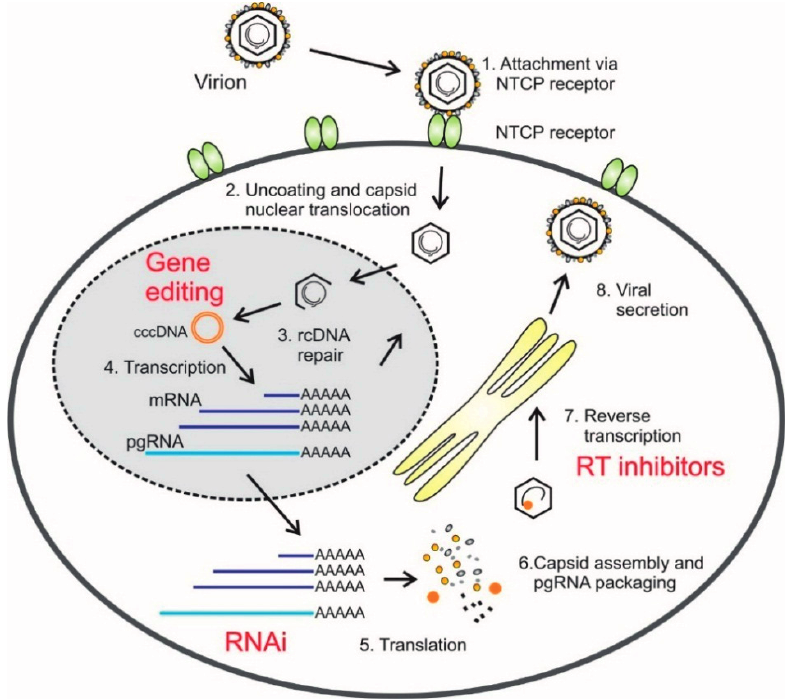
Figure 1. Diagram of hepatitis B virus (HBV) replication cycle. Attachment to the sodium taurocholate co-transporting polypeptide (NTCP) receptor, and possibly other receptors too, is the initiating event of infection ( 1 ); After uncoating and nuclear translocation of the capsid, relaxed circular DNA (rcDNA) is delivered to the nucleus ( 2 ); rcDNA is then repaired to form covalently closed circular DNA (cccDNA) ( 3 ); which is the template for transcription of viral RNA ( 4 ); Viral mRNA is translated ( 5 ); The pre-genomic RNA (pgRNA) is then packaged into capsid particles together with the viral Pol ( 6 ); The pgRNA is reverse transcribed in the nucleocapsid ( 7 ); And the viral particles are secreted via the endoplasmic reticulum ( 8 ). Sites of action of licensed and potentially therapeutic agents are indicated in red text. Viral cccDNA may be disabled by methods that employ gene